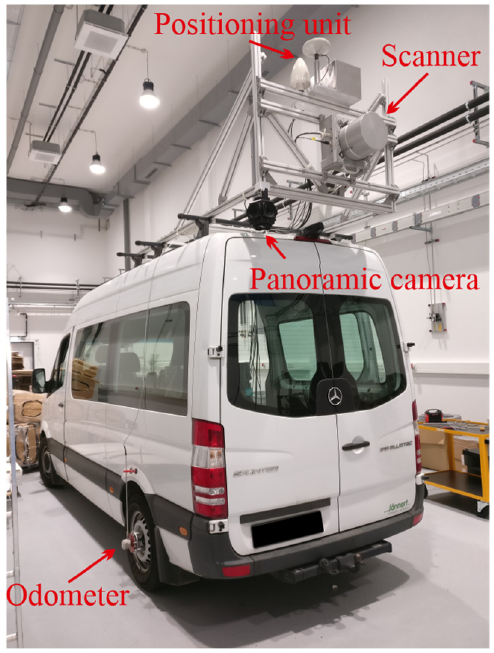
Figure 2. Mobile mapping vehicles employ a positioning and orientation system, an odometer, a panoramic camera and a multispectral LiDAR system, with which the data was acquired. The measurement route covered various residential areas in and around Freiburg (Germany) to capture as heterogenous data as possible.